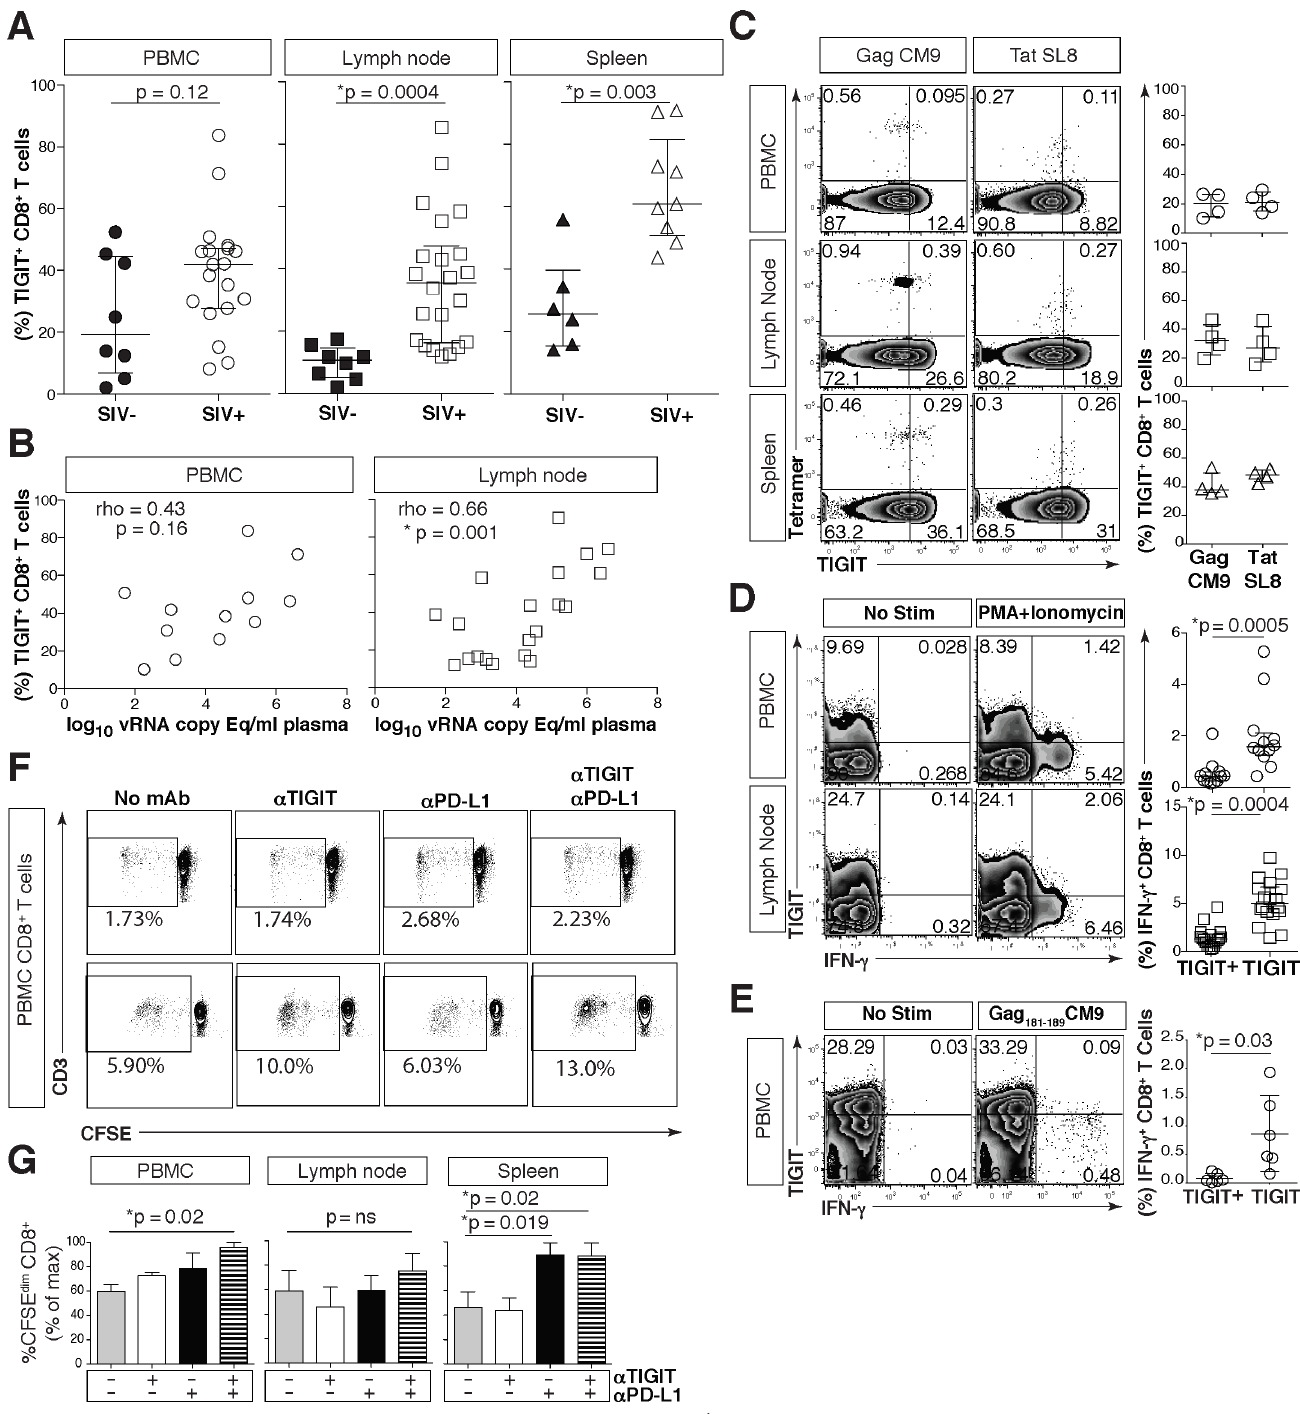
Fig 7. Phenotypic and functional assessment of rhTIGIT expression on CD8 + T cells. Cryopreserved rhesus macaque PBMCs were thawed, phenotyped and assessed for function. (A) Graphs show frequency (%) of rhTIGIT + CD8 + T cells from PBMCs (circle), LNs (square), and spleen (triangle) in SIV-uninfected (filled) and SIV-infected (open) animals (SIV-uninfected PBMCs, n = 8; SIV-infected PBMCs, n = 19; SIV-uninfected LNs, n = 8; SIV-infected LNs, n = 22; SIV-uninfected spleen, n = 6; SIV infected spleen, n = 9). P values were calculated with Mann-Whitney U tests. (B) Graphs show correlation of frequency (%) of rhTIGIT + CD8 + T cells in PBMCs (circle) and lymph nodes (square) from SIV-infected animal against plasma SIV viral load log 10 vRNA copy Eq/ml (PBMCs, n = 12; LNs, n = 20). vRNA copy Eq, viral RNA copy equivalents. Spearman ’ s rho tests were performed for correlations. (C) Representative flow cytometry plots of tetramer stains for Mamu-A * 01 restricted SIV-Gag CM9 and SIV-Tat SL8 specific CD8 + T cells from PBMC, LNs, and spleen, in a